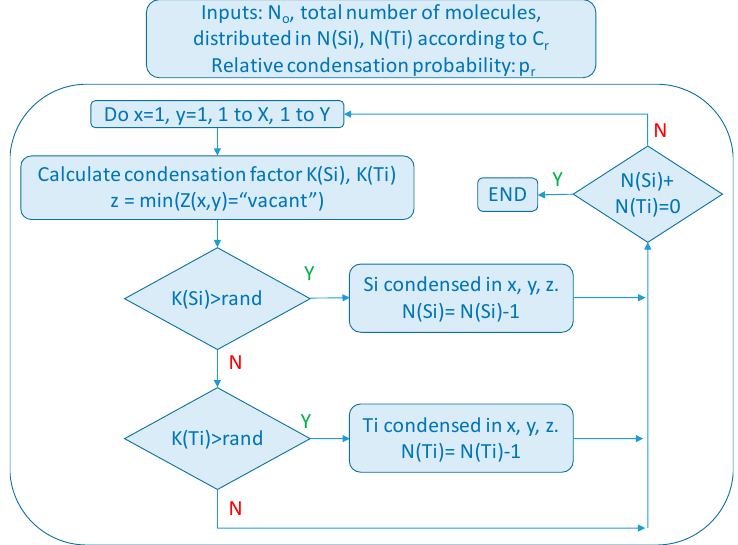
Figure 1. Basic flowchart describing the random process for the simulation of the condensation process of OrgSil/Ti-alk hybrids.